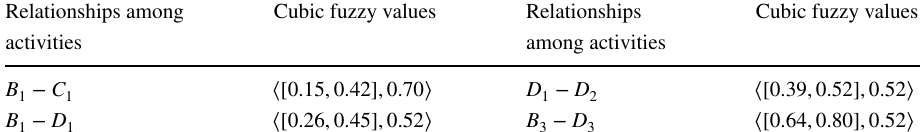
Fig. 11 The CFGS related to the piping project of a three-unit